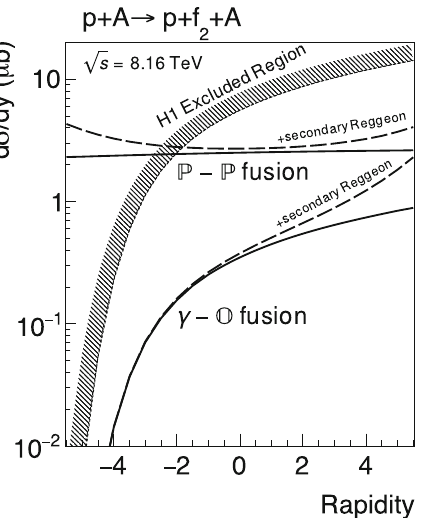
Fig. 3 Indicative predictions of the Pomeron–Pomeron fusion and γ - Odderon fusion contributions to the cross section for pA → p + f 2 + A √ s NN = 8 . 16 GeV. The dashed as a function of the f 2 rapidity for curves show the effect of including a secondary Reggeon contribution. The effect of changing the absorptive cross section σ tot ( f 2 N ) has a smaller effect than that for AA (cid:4) collisions which was shown in Fig. 2. Here we take σ tot ( f 2 N ) from (17) with σ 0 = 15 . 7 / 2 mb and (cid:10) = 0 . 055. The shaded band indicates the region predicted to be excluded for the Odderon signal if we were to use the upper limit for σ(γ p → f 2 p ) of 16 nb found at HERA [52], rather than 1 nb